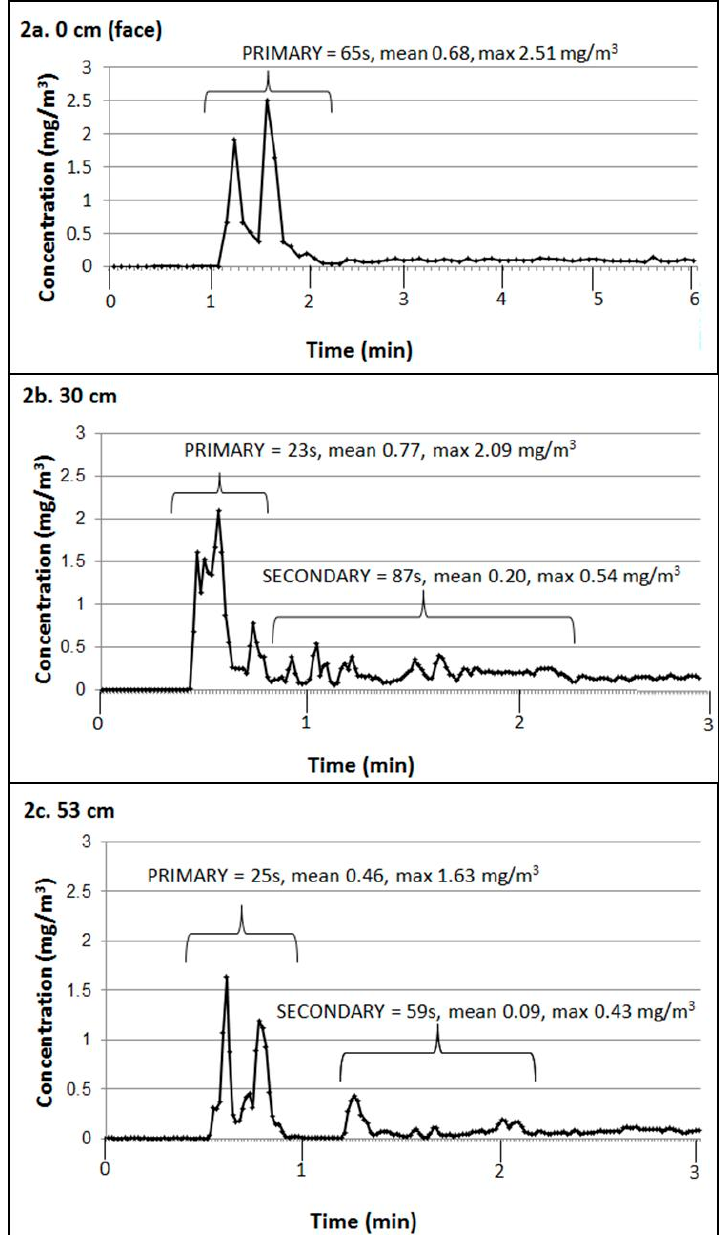
Figure 2. Measurements of PM 4 concentration and duration of primary and secondary talc clouds formed when Subject A applied talcum powder. Simultaneous measurements were taken in the personal breathing zone at the face (Figure 2a) and 30 cm from the face (Figure 2b), plus an area measurement taken 53 cm from the face (Figure 2c).